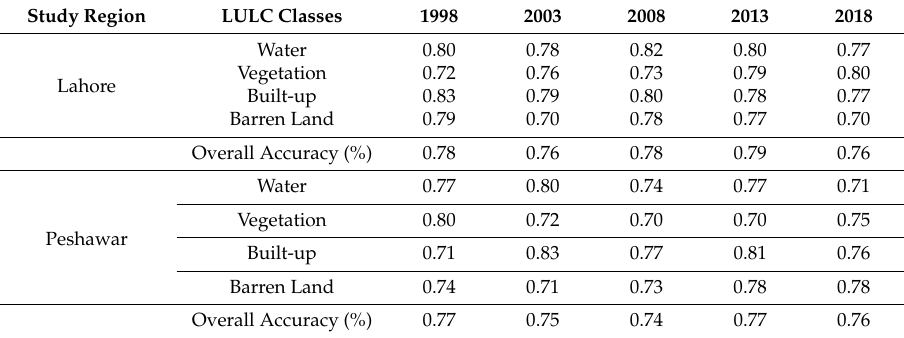
Table 2. Accuracy assessment of land use classification in Lahore and Peshawar (%).